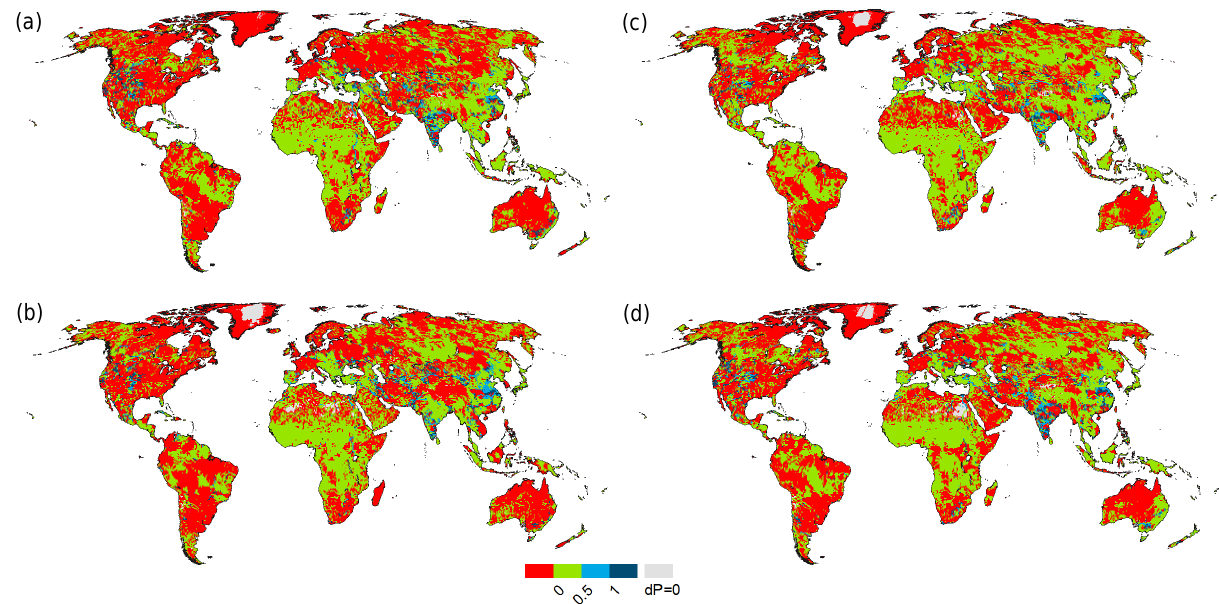
Figure B4. Indicator B n quantifying the relative dominance of anthropogenic impact on Q change (i.e., Q − Qnat ) as compared to the change in Q (Eq. 5) from 1941–1970 to 1971–2000. Grey color indicates that the change in Q is zero, such that B n cannot be computed. Red color indicates areas where B n is less than 0, and the change in anthropogenic impact is not consistent with the change in Q ; therefore, the anthropogenic impact is not the dominant driver for change in Q . Results are shown for WaterGAP as driven by the climate forcings GSWP3 (a) , PGFv2.1 (b) , WFDEI_hom (c) , and WFD (d)